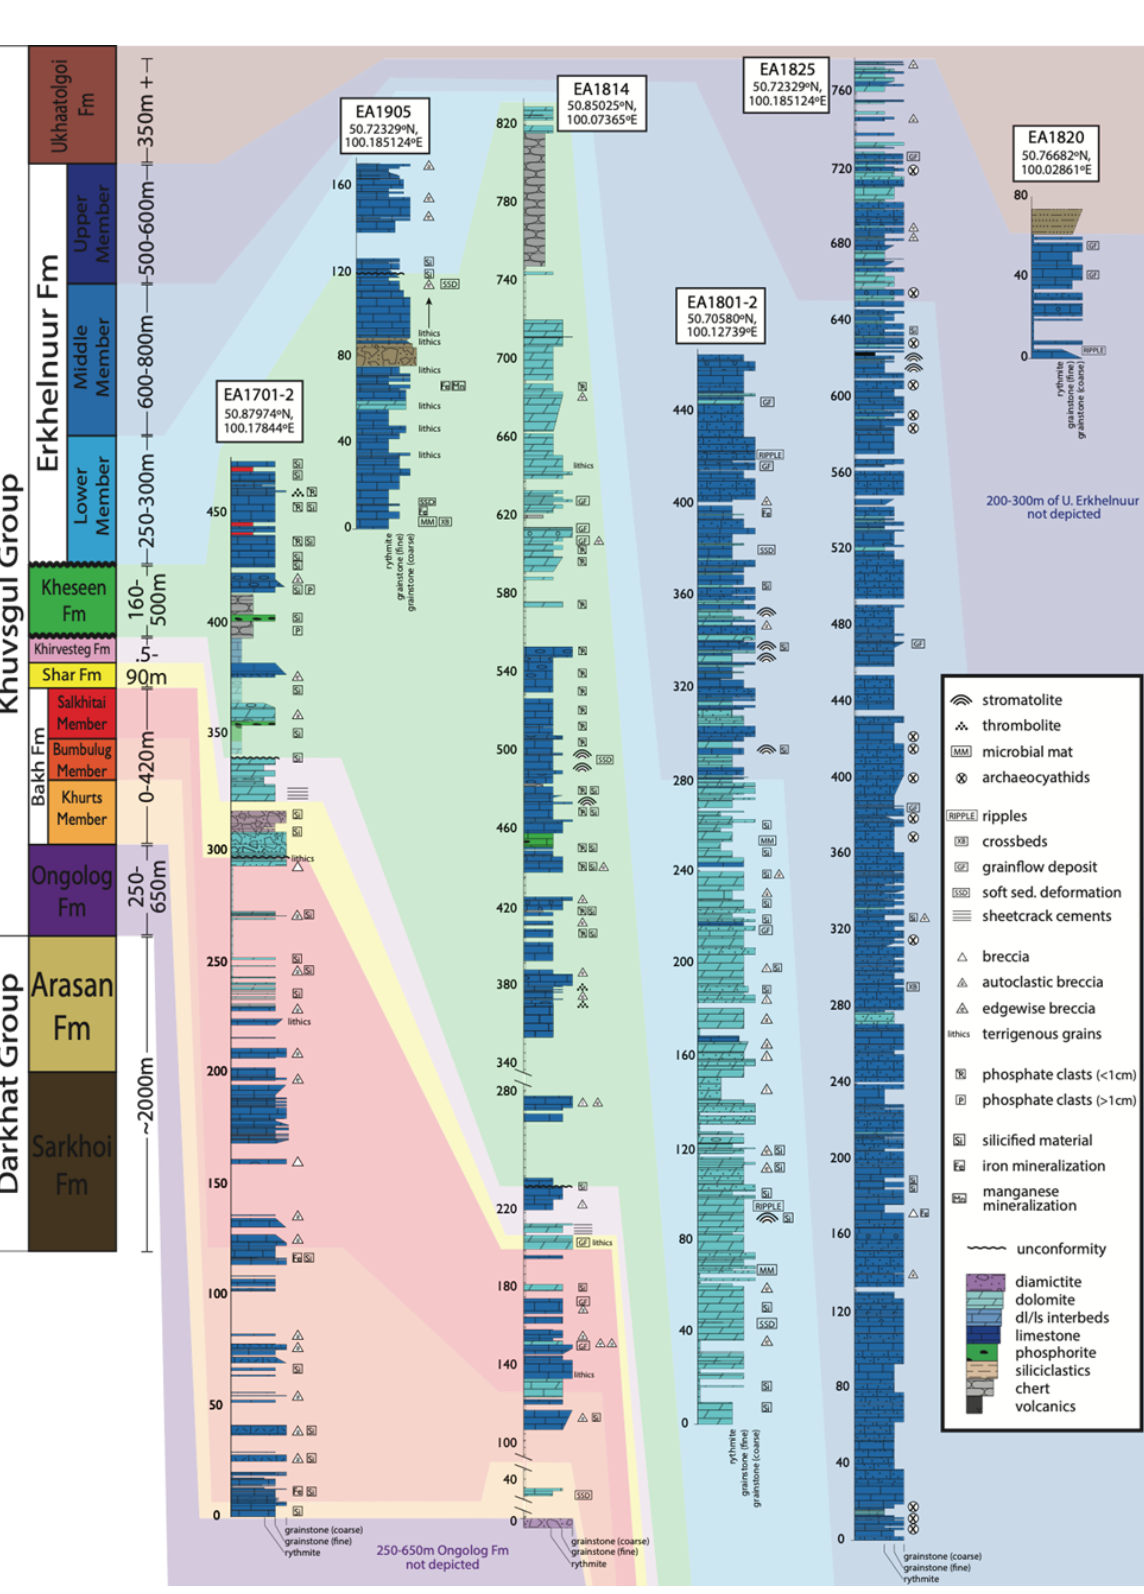
Fig. 5. Measured stratigraphic sections from Khuvsgul Group type-localities. All section locations are depicted in Fig. 2, while coordinate locations shown above are from the stratigraphic base of each